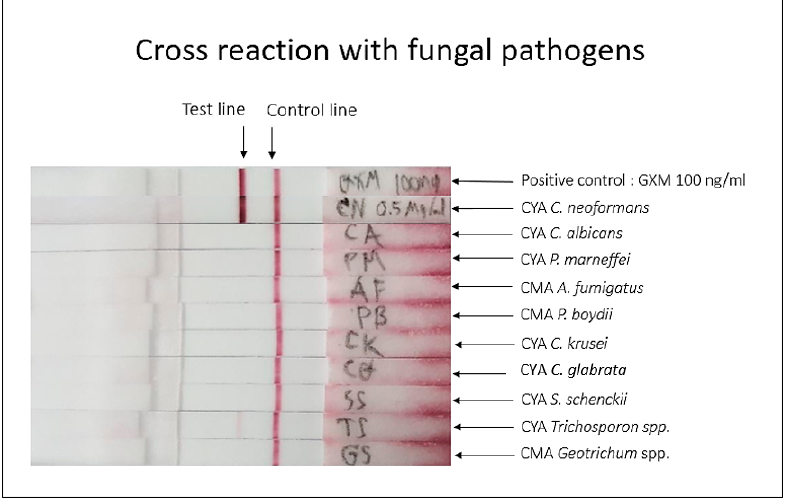
Figure 7. Cross-reactivity of mAb 18B7 sandwich ICT strip with fungal antigens from different pathogenic species. The cytoplasmic antigens of various pathogenic fungi were investigated the cross-reactivity. Positive control is GXM from H99, at concentration 100 ng/mL. Other pathogenic fungal antigens were used at concentration 10 µ g/mL. Cross-reactivity was detected with Tri- chosporon sp.